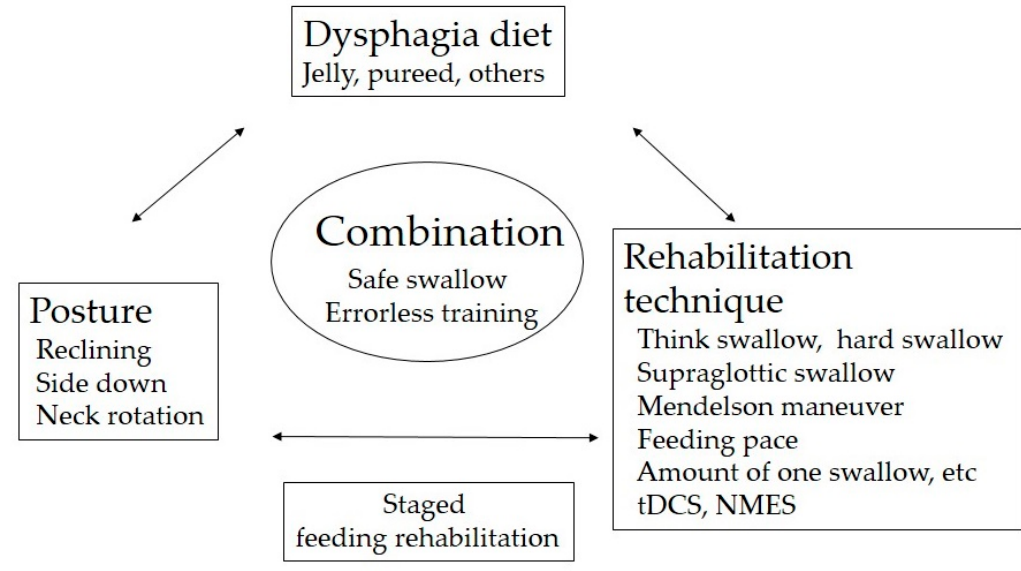
Figure 12. Flow chart of dysphagia rehabilitation. Balloon: Balloon dilatation of Upper Esophageal Sphincter, tDCS: transcranial Direct Current Stimulation, NMES: neuromuscular electrical stimulation.